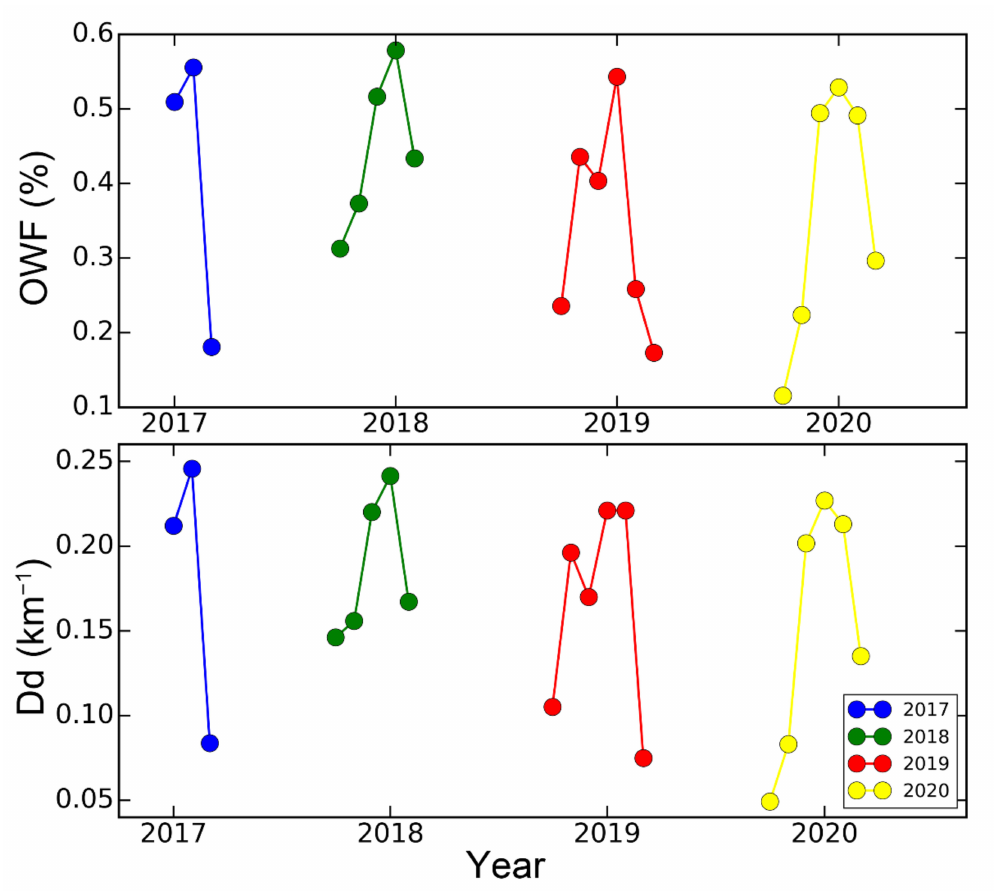
Figure 16. Seasonal variation in the water surfaces of the river networks in the study area. (2) Seasonal Variation